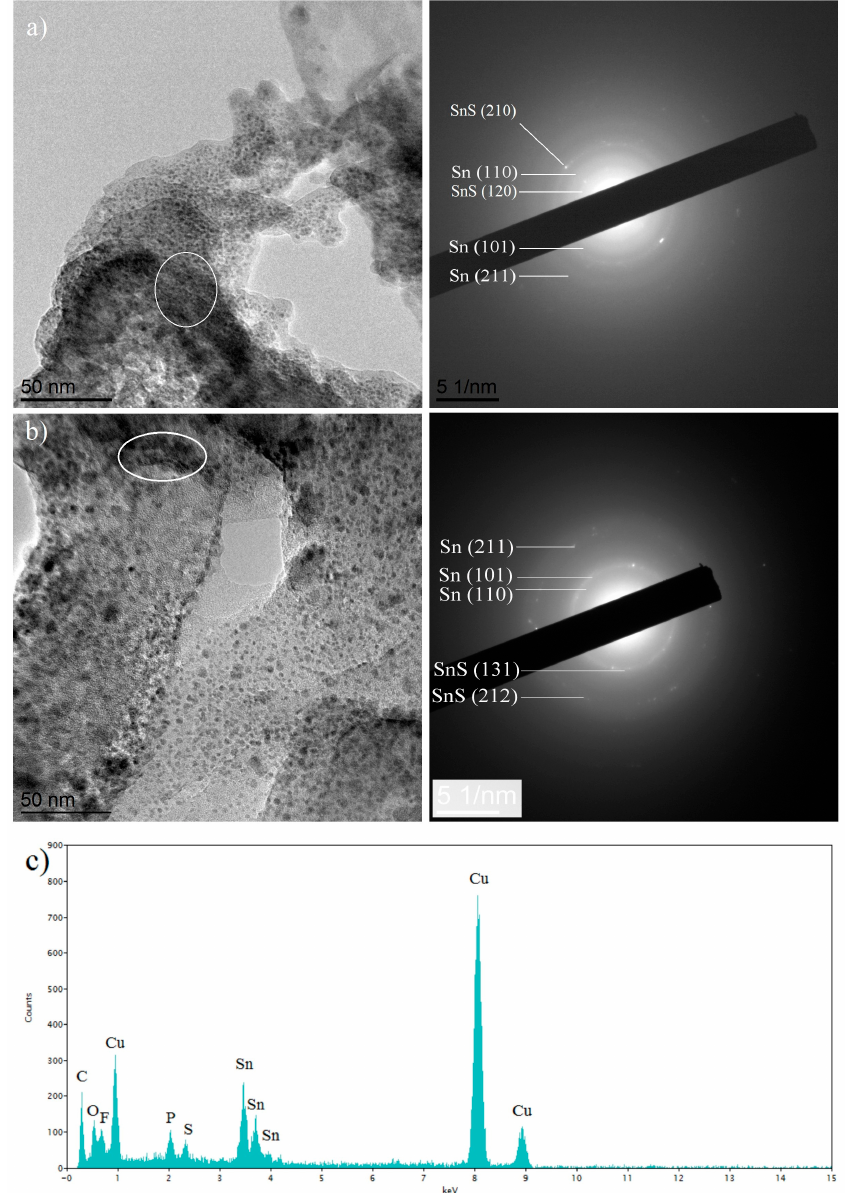
Figure 6. High resolution TEM (HRTEM) images with SAED and EDS results of the SnS/C composite anodes after 200 cycles. ( a ) 10SnS/AG, ( b ) 10SnS/MCMB, and ( c ) the results of EDS on 10SnS/AG.